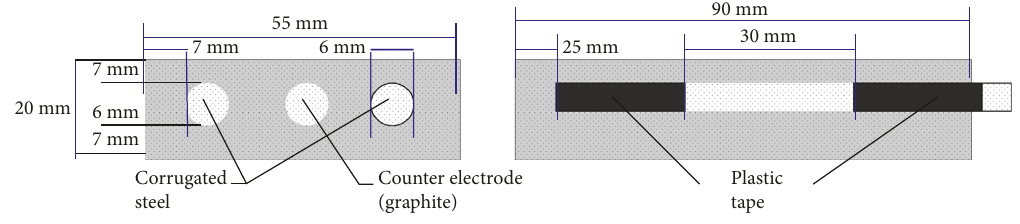
Figure 1: Specimen